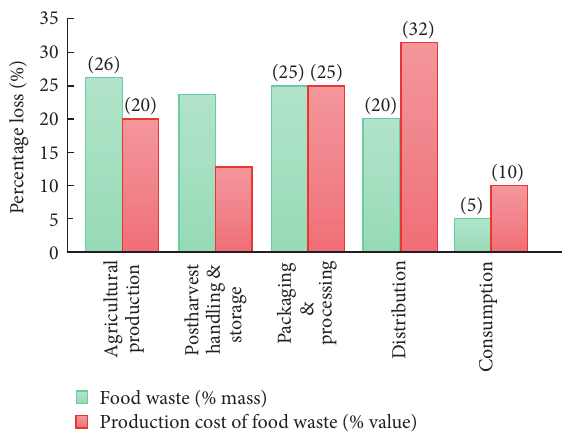
Figure 2: Comparison between food waste quantities (%, by mass) and the cost of food waste (%, by value) in each stage of the food supply chain in South Africa